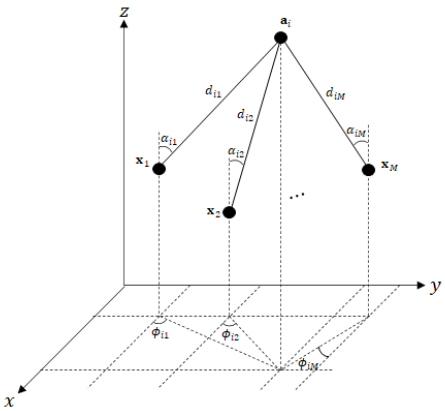
Figure 1. The relationship among an anchor and multi-target in a 3-D